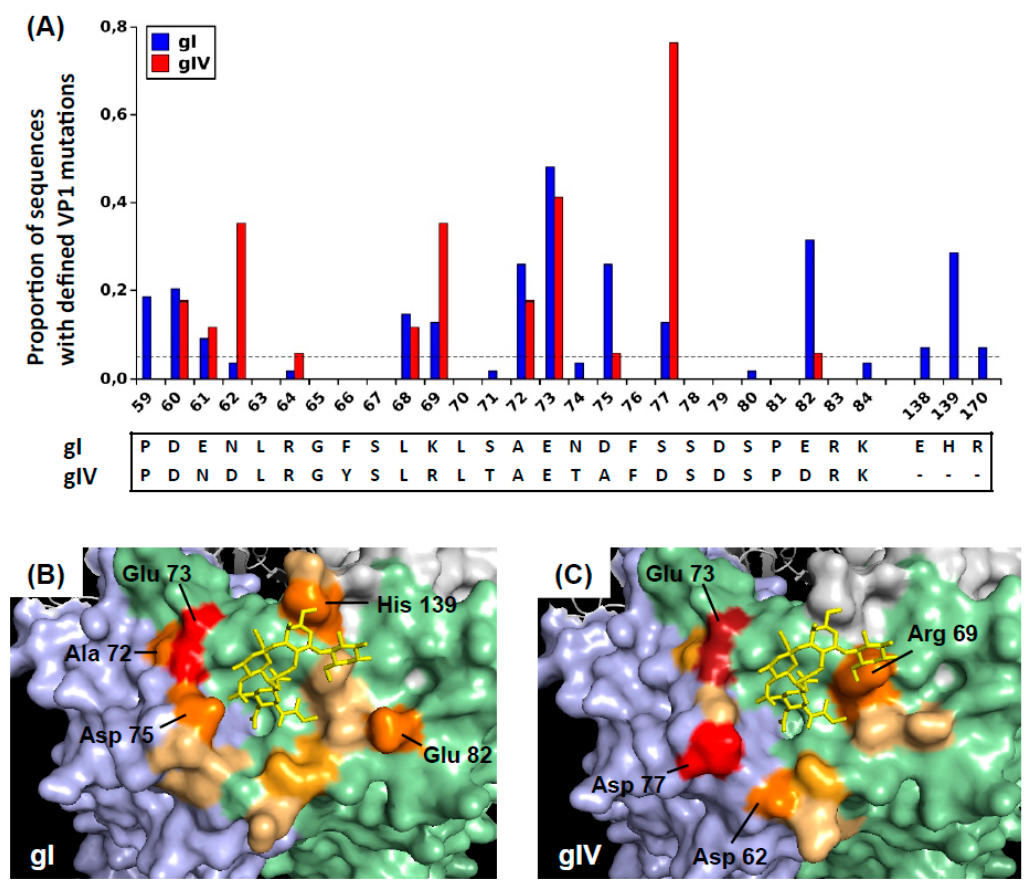
Figure 2. Distribution of VP1 mutations observed in patients with genotype I and genotype IV virus. ( A ) Prevalence of VP1 mutations among sequences from 54 patients with genotype I BKPyV (26 typing region sequences AA 55–110, 28 full-length VP1 sequences) and 17 patients with genotype IV virus (typing region sequences only). Localisation of observed mutations on genotype I ( B ) and genotype IV ( C ) VP1 pentamers. BKPyV VP1 pentamers (4MJ0 [36]) were visualized with Pymol, and the genotype IV-specific BC-loop residues were added using the mutate function. Adjacent VP1 monomers are coloured light blue, light green and light grey, and the GD3 oligosaccharide is shown in a yellow stick representation. Mutations with prevalence > 5% are coloured in progressively darker shades on the following scale: mutation prevalence 5–15% lightorange; 15–25% brightorange; 25–35% orange; 35–45% firebrick; > 45% red. The files used to prepare panels ( B ) gI_VP1Muts_Orange.pse and ( C ) gIV_VP1Muts_Orange.pse are included in the Supplementary Materials.